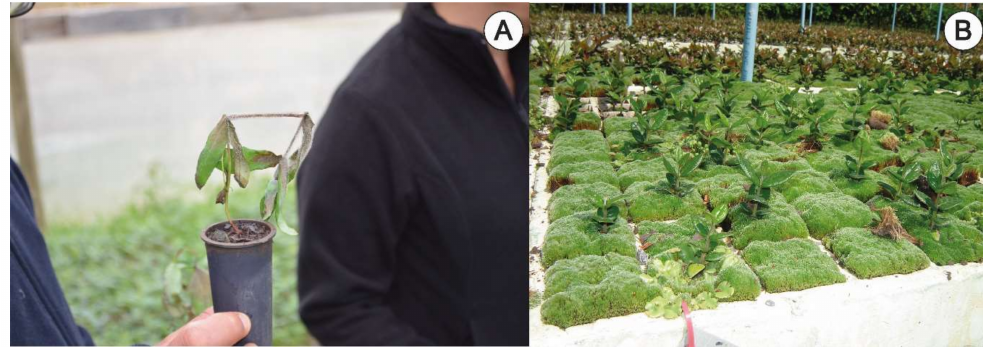
Figure 3. ( A ) Incidence on Botrytis cinerea on Eucalyptus globulus plants; ( B ) moss growth on the